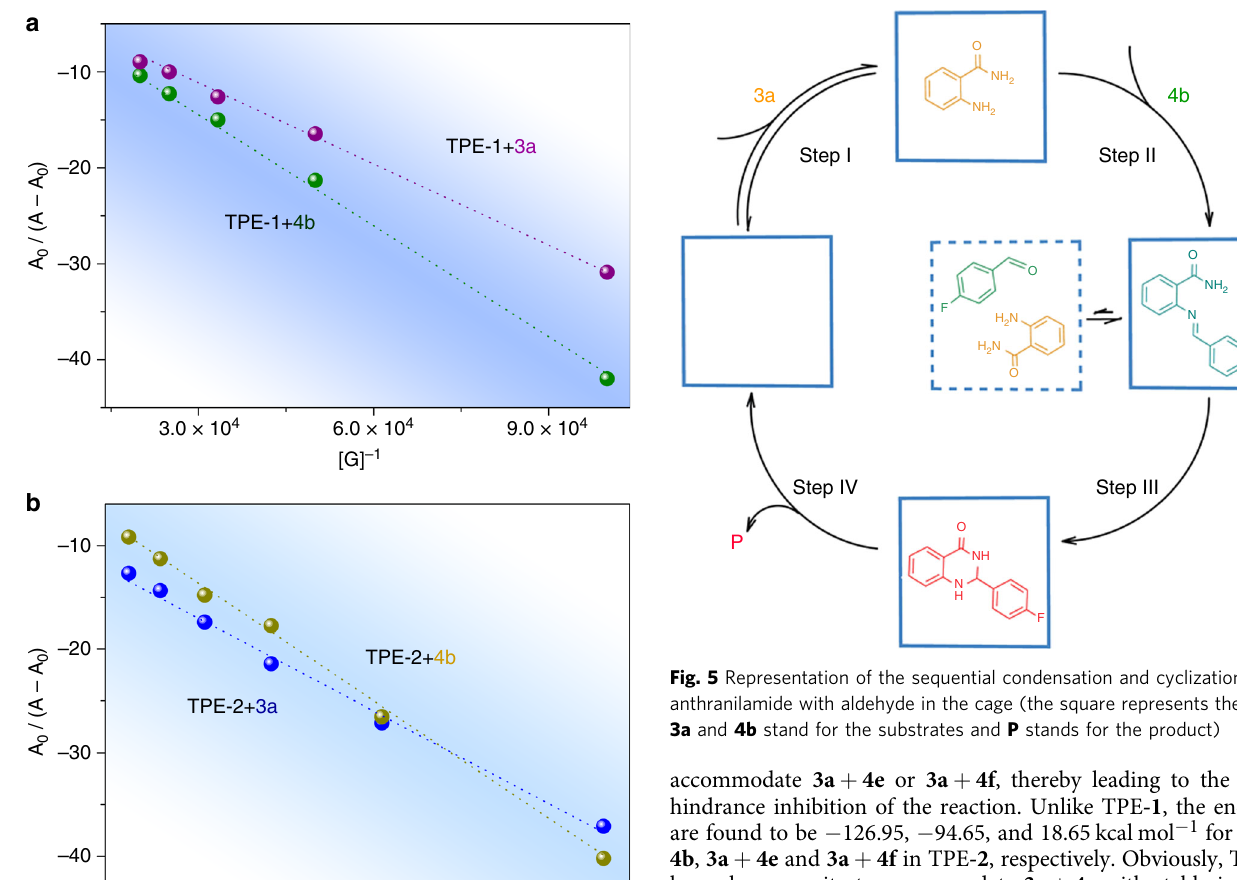
(Supplementary Fig. 47), indicating that the product was not adsorbed in the cages.